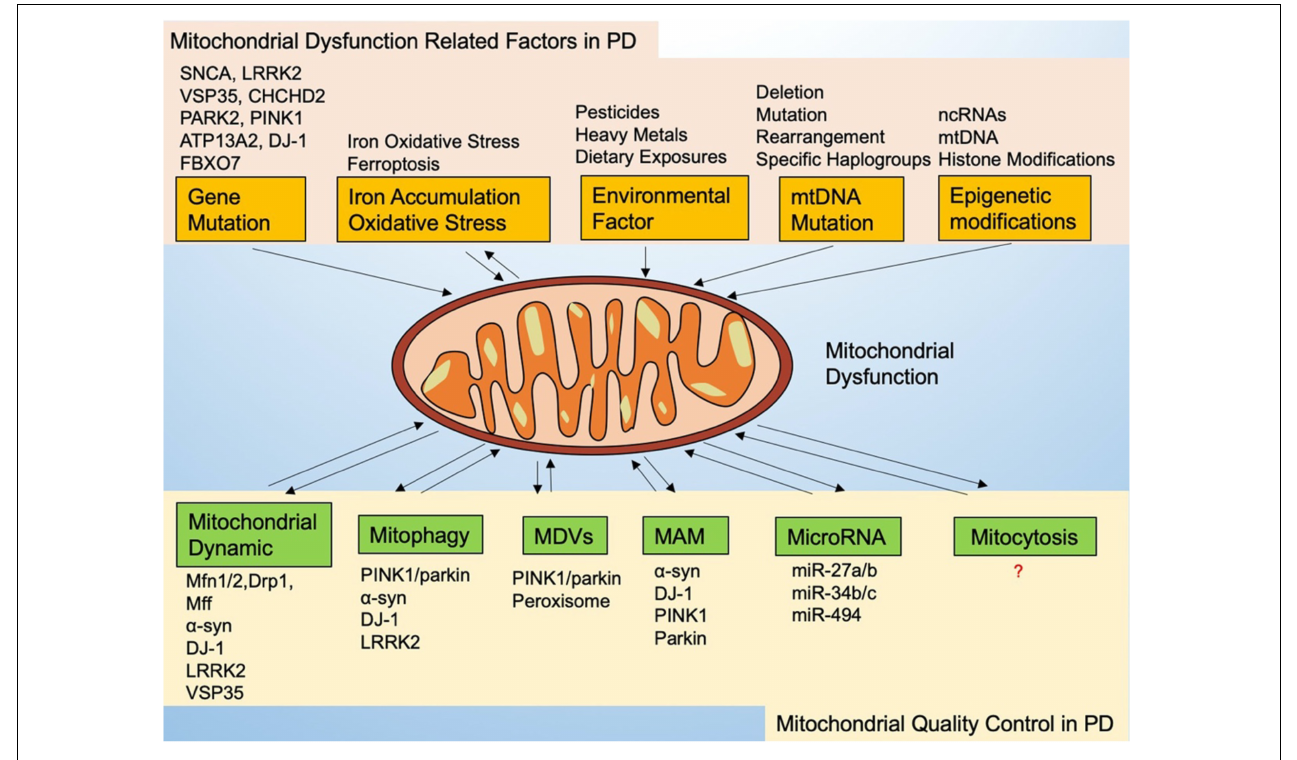
FIGURE 1 | Mitochondrial dysfunction-related factors and mitochondrial quality control in Parkinson’s